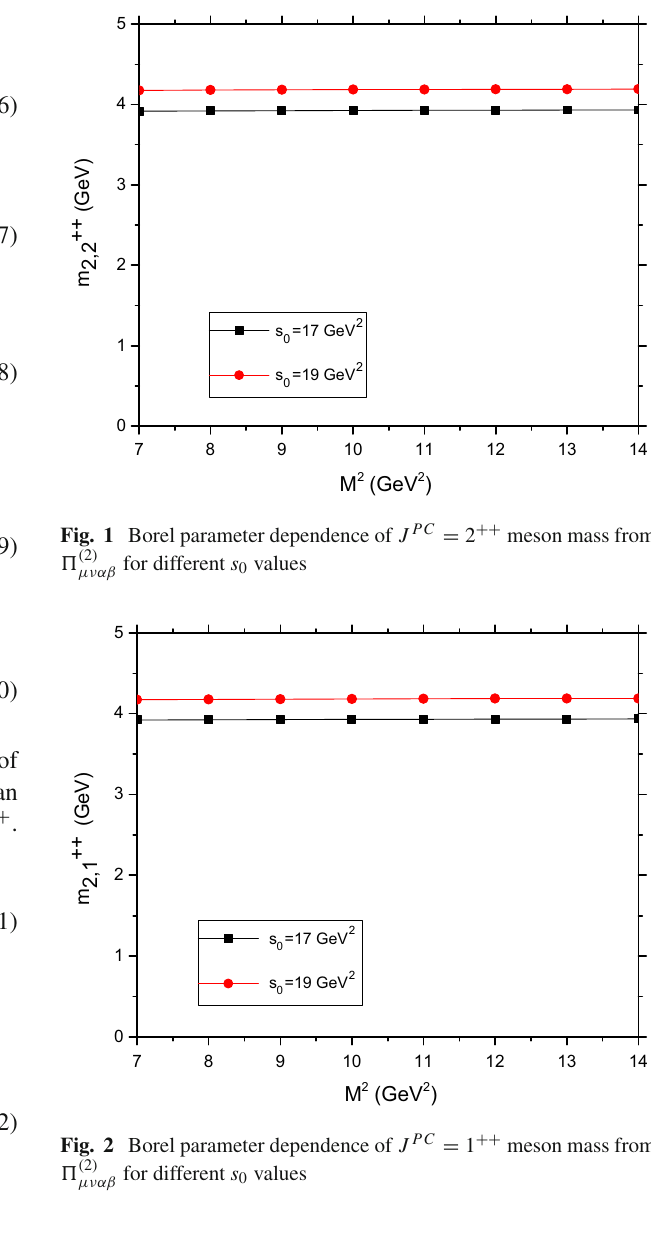
As is stated earlier, to match (cid:10) phen with (cid:10) QCD ,